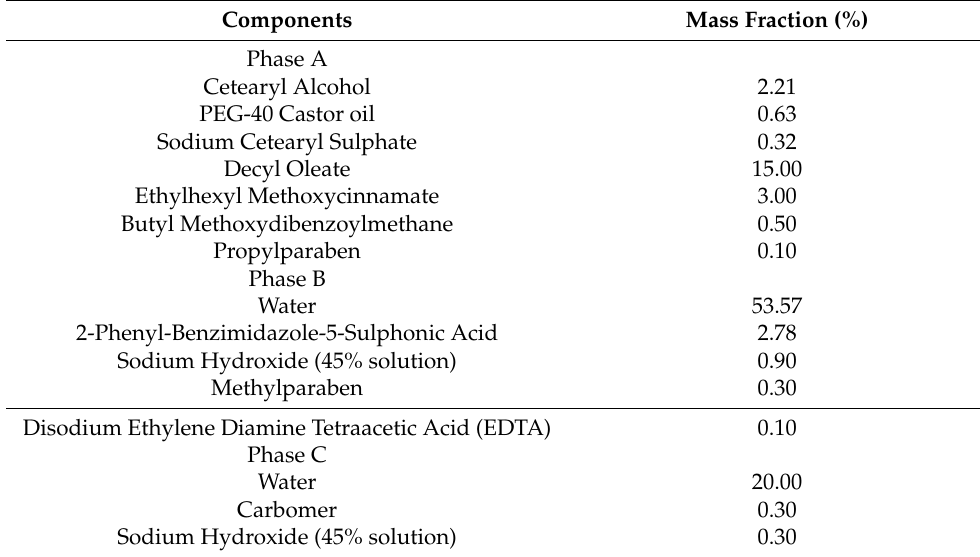
Table 2. Sunscreen formula tested in the